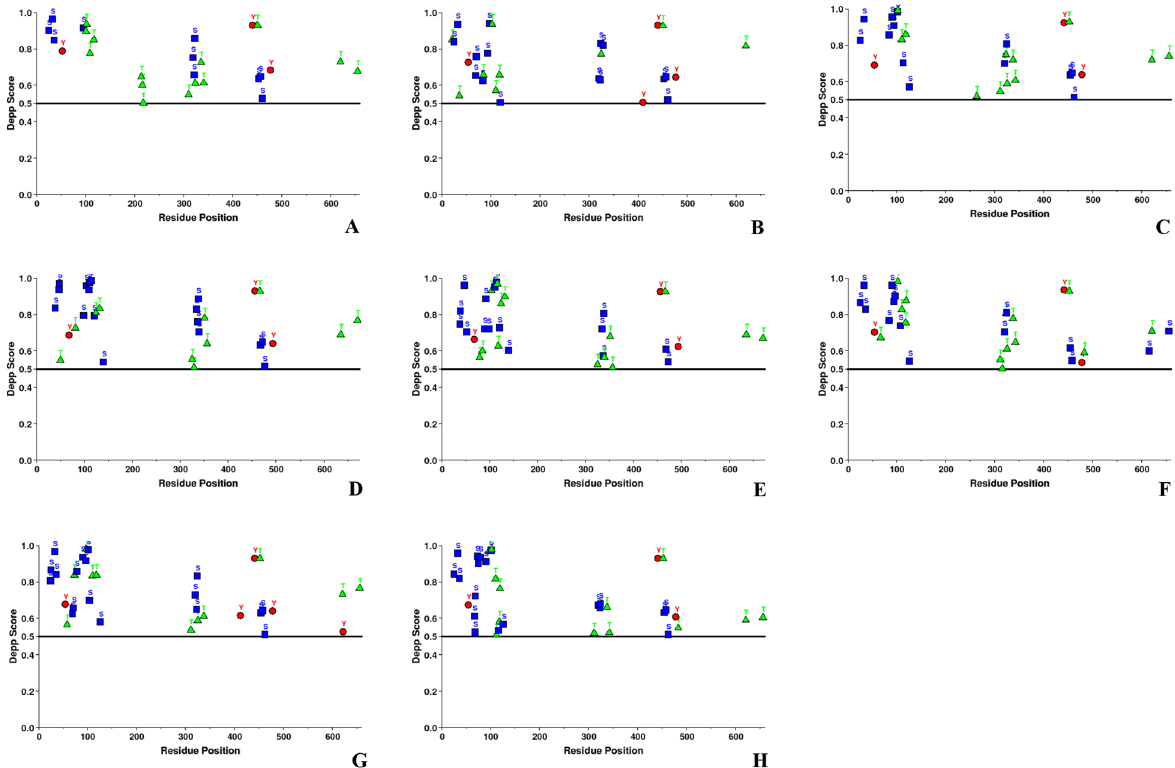
Fig. 4 Prediction of phosphorylation sites showing the scores of phosphorylated residues (Ser, Thr, Tyr) along with the depicted scores within ORF2. A JF443720 (GT 1); B M74506 (GT 2); C AB222182 (GT 3); D GU119961 (GT 4); E AB573435 (GT 5); F AB602441 (GT 6); KJ496143 (GT 7); and H KX387865 (GT 8). Graphs A – H represent the phosphorylation patterns of the ORF2 sequences of HEV. The score was computed using DEPP (disorder enhanced phosphorylation prediction). A threshold value of 0.5 was set to distinguish between ordered and disordered region along the genome (line). The predicted phosphorylated residues above the threshold are represented as Ser (S): Blue, Thr (T): Green, and Tyr (Y):